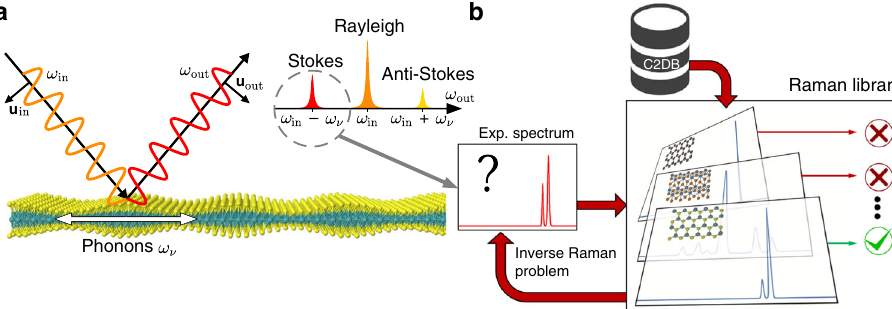
Fig. 1 Schematic view of Raman scattering process and inverse Raman problem. a Raman scattering processes, in which incident photons of polarization and frequency ω are scattered into u and ω under emission (or absorption) of a phonon with frequency ω ν . Only zero momentum phonons u in in out out contribute to fi rst-order Raman processes but, for illustrative purposes, a fi nite momentum phonon is shown here. In a typical output spectrum, the Rayleigh (elastic), Stokes and anti-Stokes lines are observed. b Given an experimental spectrum, the Raman library based on the open Computational 2D Materials Database (C2DB) can be used to tackle the inverse Raman problem, i.e. identifying the underlying material based on its Raman